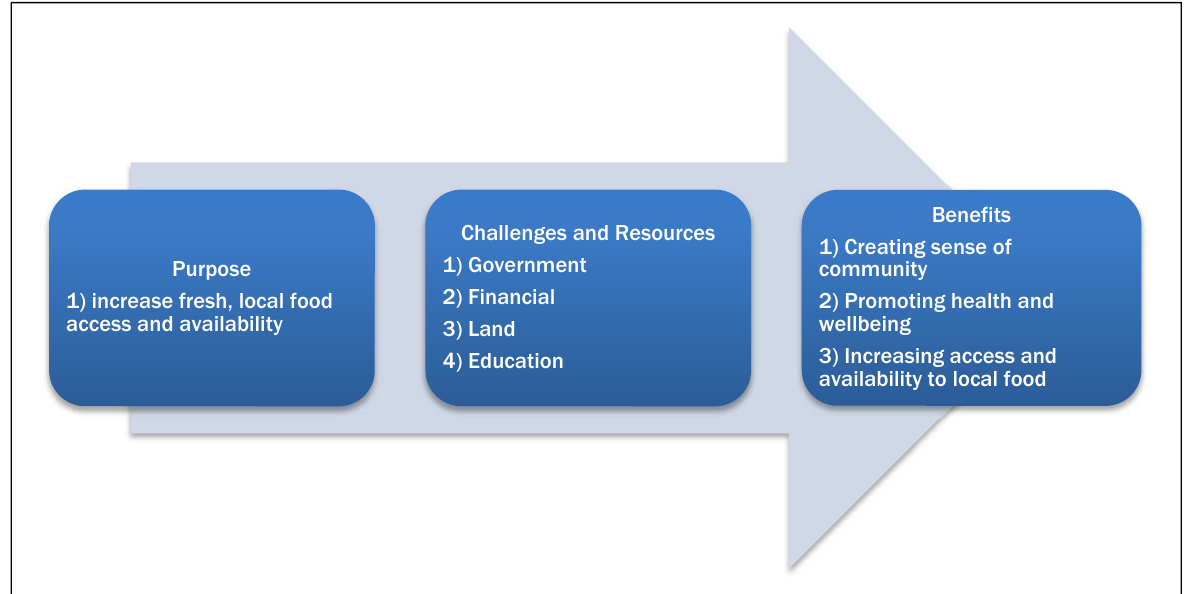
Figure 1. Community Food Security